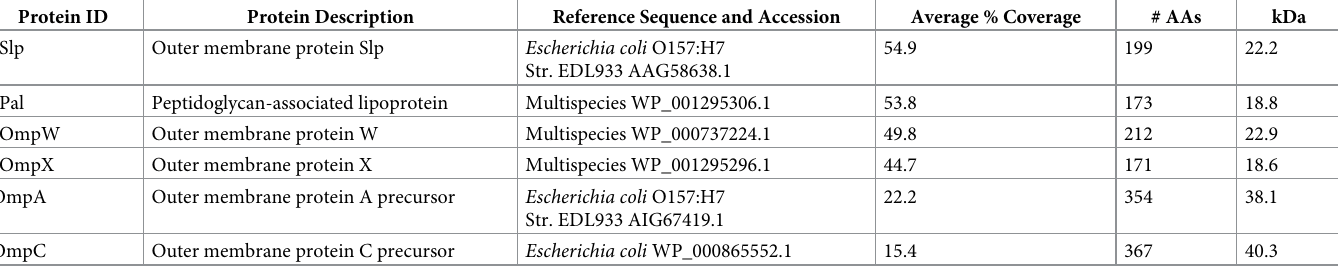
Table 3. Protein identification using LC MS/MS. Summary of the outer membrane proteins found to be possible identifications of the protein recovered from Co-IP. Proteins are listed in order of decreasing sequence coverage, and proteins that were identified in three of three LC MS/MS analyses are noted. Protein ID